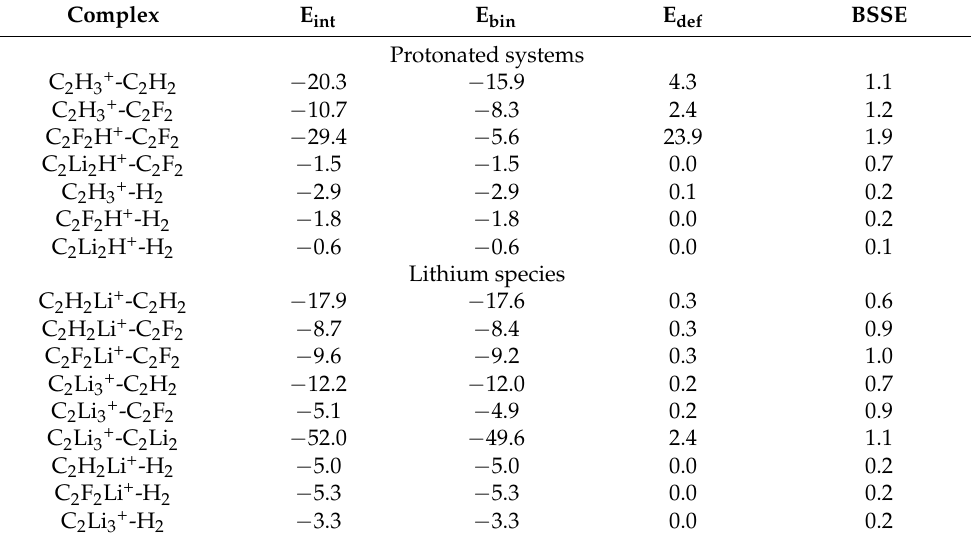
Table 2. The interaction, binding and deformation energies, E int , E bin (corrected for BSSE) and E def , respectively, for complexes analyzed in this study. The BSSE correction is included (all in kcal/mol). Complex E int E bin E def BSSE Protonated